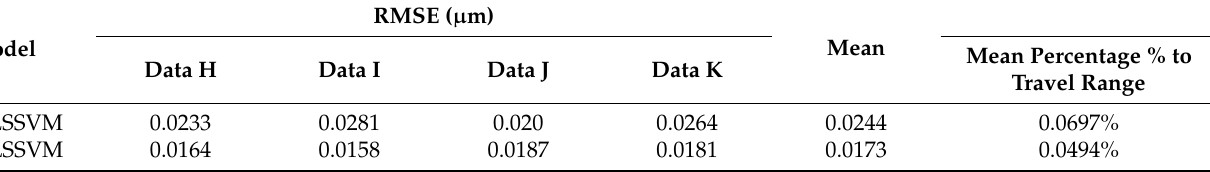
Table 5. Comparison of tracking control with PID-LSSVM approach on test data H, I, J, and